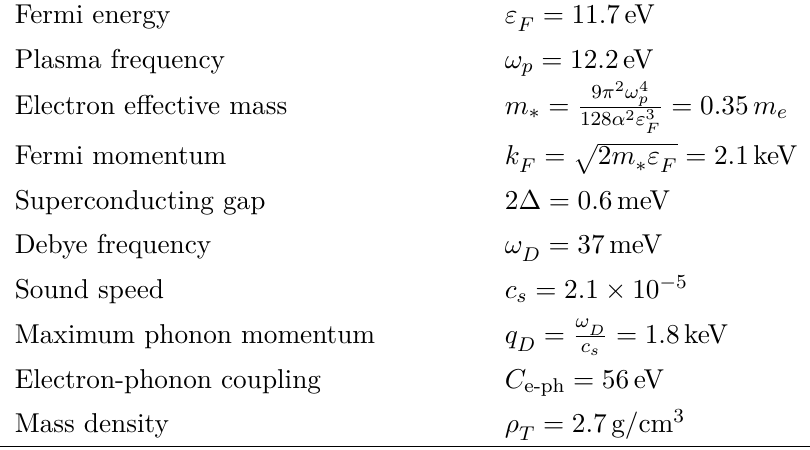
Table 2 . Material parameters for aluminum